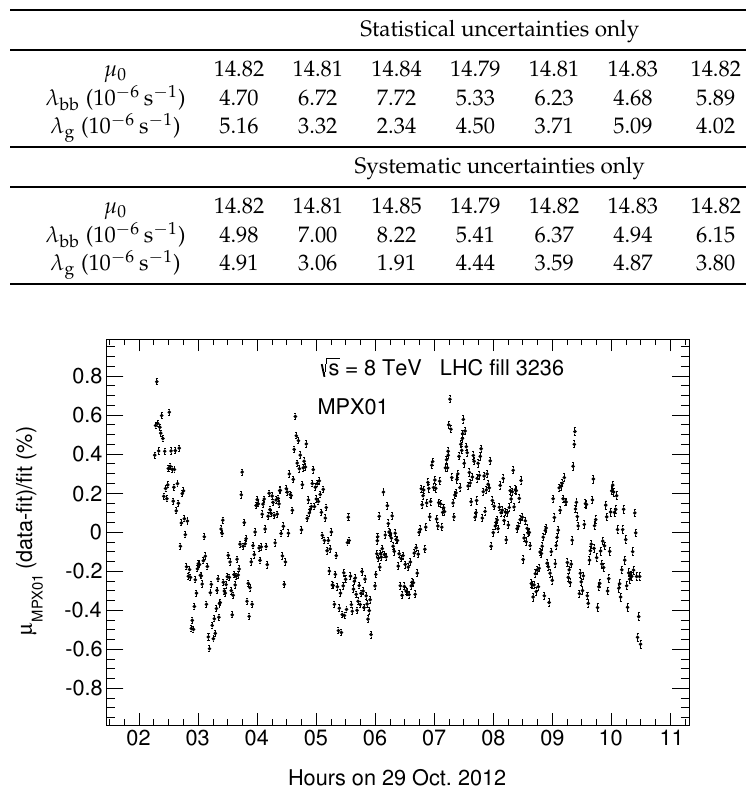
Figure 12. Relative difference between data and fitted average number of interactions per bunch crossing as a function of time seen by MPX01. The relative deviations between data and fit have an RMS of 0.3%. The statistical uncertainties ∆ µ / µ per data point are indicated and vary from √ √ 0.0094 2.65% to 0.0125 2.65% where the factor 2.65 is the averaged ratio of hits per interacting particle. The apparent structure is discussed in the text. LHC fill 3236. Taken from Ref.